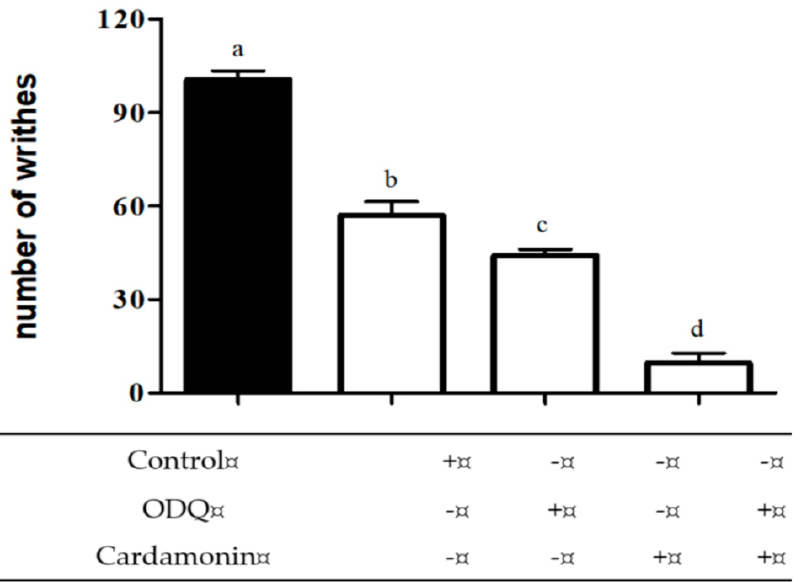
Figure 5. E ff ect of ODQ (2 mg / kg; i.p.) pre-treatment on antinociceptive activity of cardamonin (1 mg / kg; i.p.) against acetic acid-induced abdominal writhing test in mice. Each column represents the mean ± S.E.M. of six mice. Statistical analysis was determined by one-way ANOVA, followed by Tukey’s post hoc test. Values with di ff erent superscript letters are statistically di ff erent from each other at p <